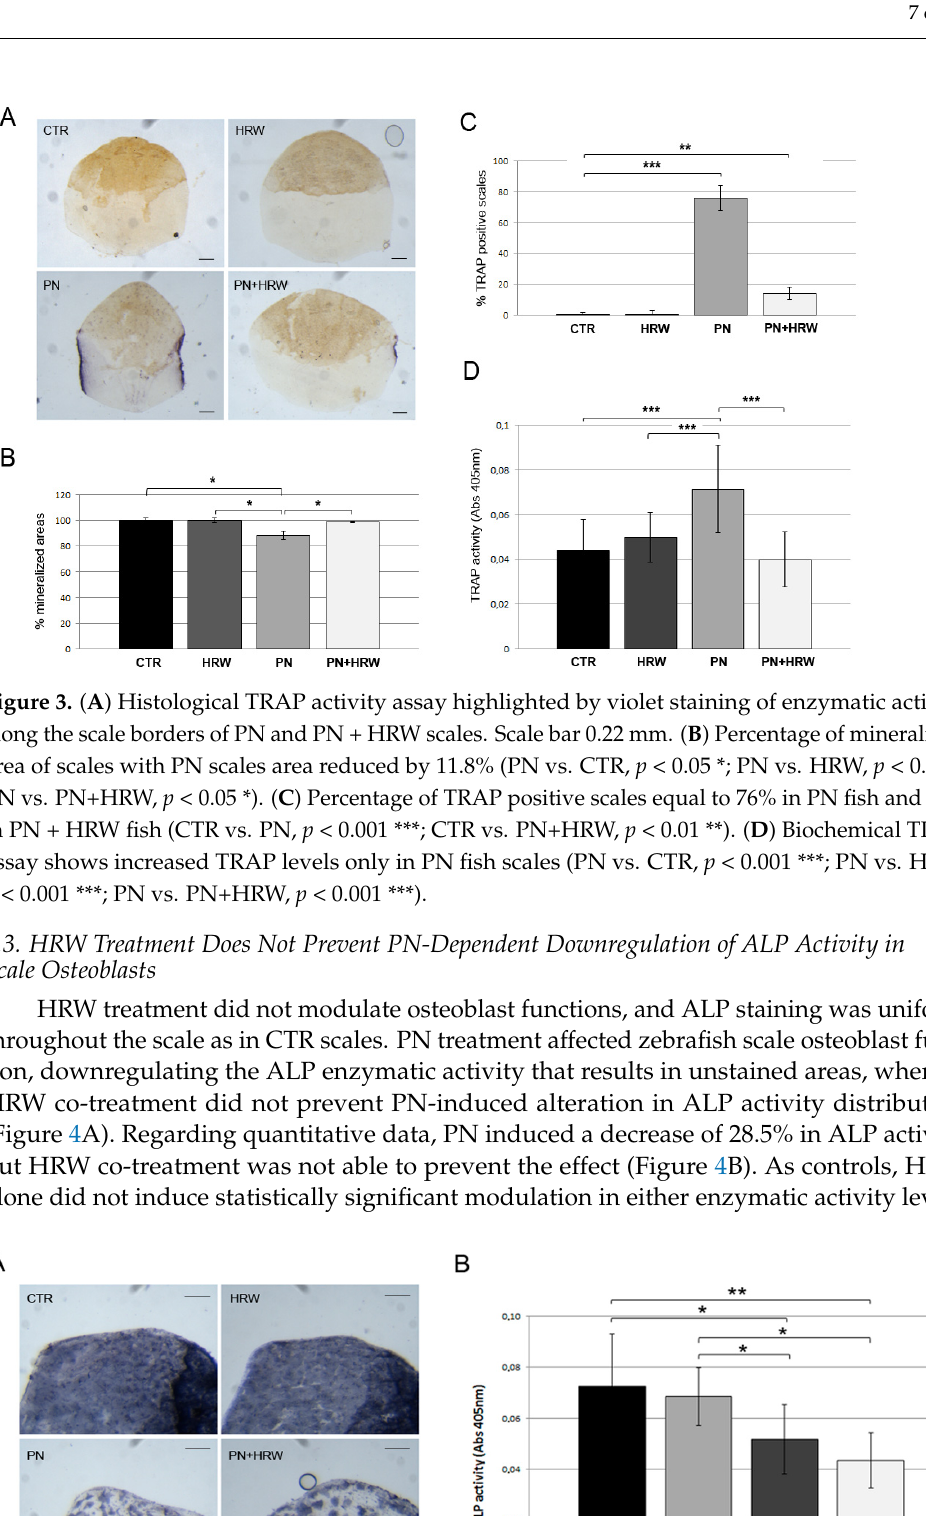
Figure 4. ( A ) Histochemical ALP activity assay highlighted by blue staining of the localization of enzymatic activity in the scale. CTR and HRW scales show normal ALP activity, while PN and PN + HRW scales show decreased ALP activity, visualized as white unstained areas. Scale bar 0.11 mm. ( B ) Quantification of ALP activity performed with biochemical assay shows decreased ALP activity on PN and PN + HRW scales (PN vs. CTR, p < 0.05 *; PN vs. HRW, p < 0.05 *; PN + HRW vs. CTR, p < 0.01 **; PN + HRW vs. HRW, p < 0.05